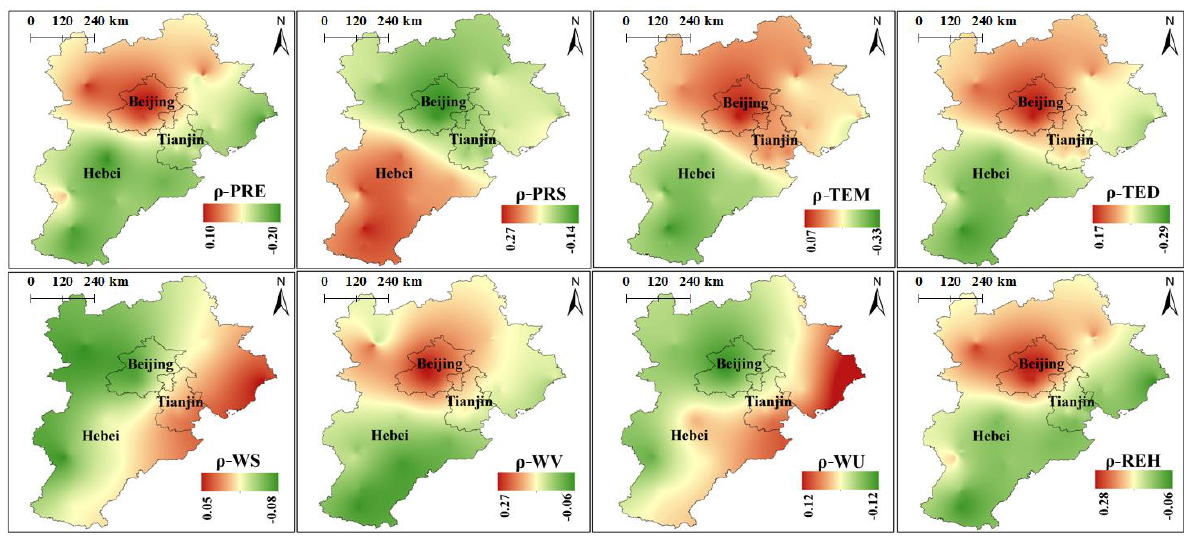
Figure 6. Spatial correlation between PM 2.5 and meteorological factors.